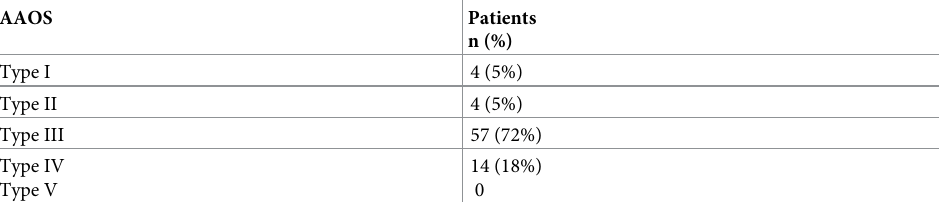
Table 2. American Academy of Orthopaedic Surgeons (AAOS) classification of the acetabular defect situations in the 79